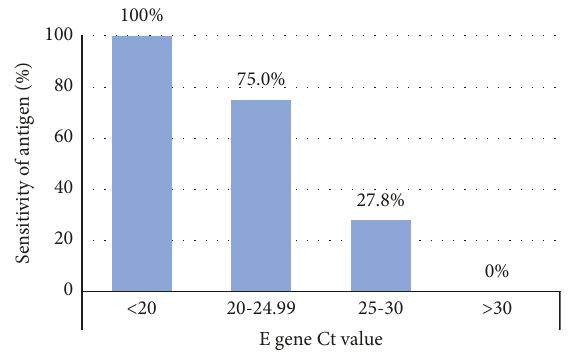
Figure 1: The sensitivity of the VTRUST COVID-19 Antigen Rapid Test with respect to Ct values of RT-PCR for the E gene. Ct cycle threshold; RT-PCR, reverse transcription-polymerase chain reaction; COVID-19 coronavirus disease